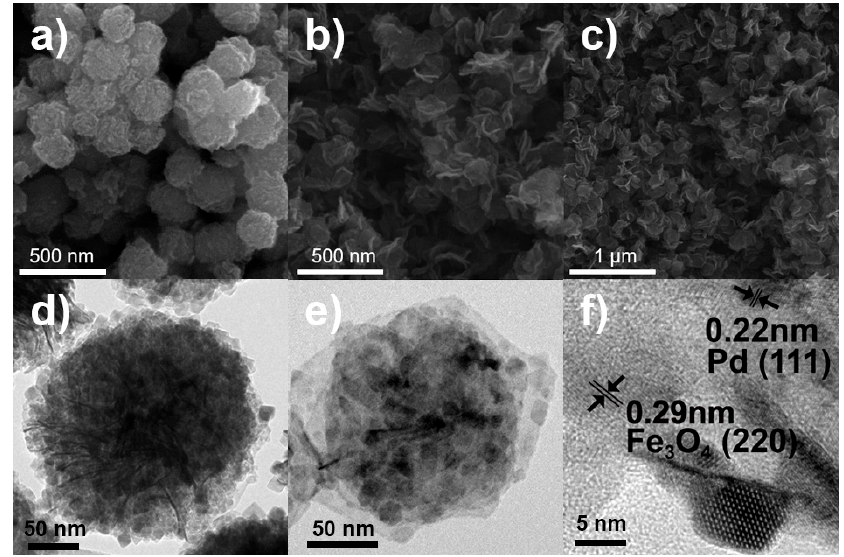
Figure 1. FE-SEM images showing ( a , b ) NPFNP-2; ( c ) NPFNP-1 and HRTEM image of NPFNP-2 showing ( d ) an individual particle; ( e ) the Pd (111) lattice spacing (0.20 nm) and ( f ) the Fe (311) lattice spacing (0.25 nm).